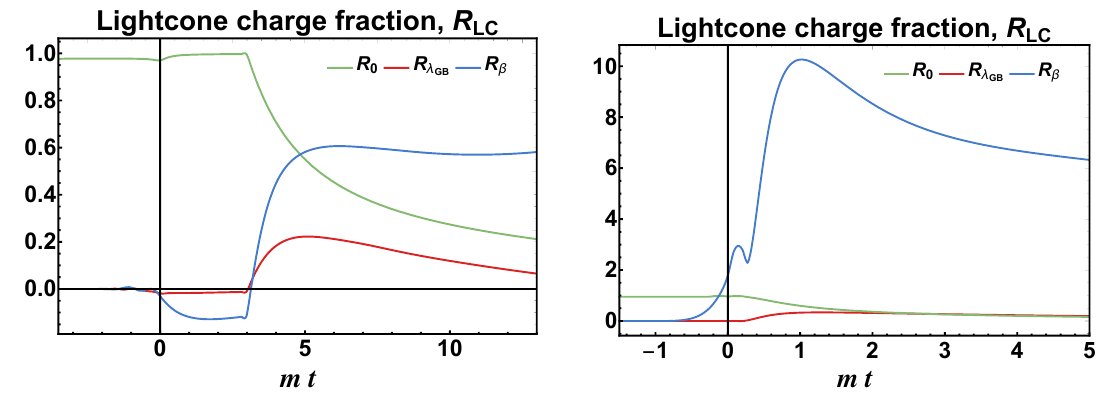
Figure 7 . Time dependence of the (cid:12)tted coe(cid:14)cients R 0 , R (cid:12) and R (cid:21) the evolution of the three contributions to the fraction of the total baryon number that ends up near one or other lightcone, R LC de(cid:12)ned in (4.1), after collisions between thick (left) and thin (right)